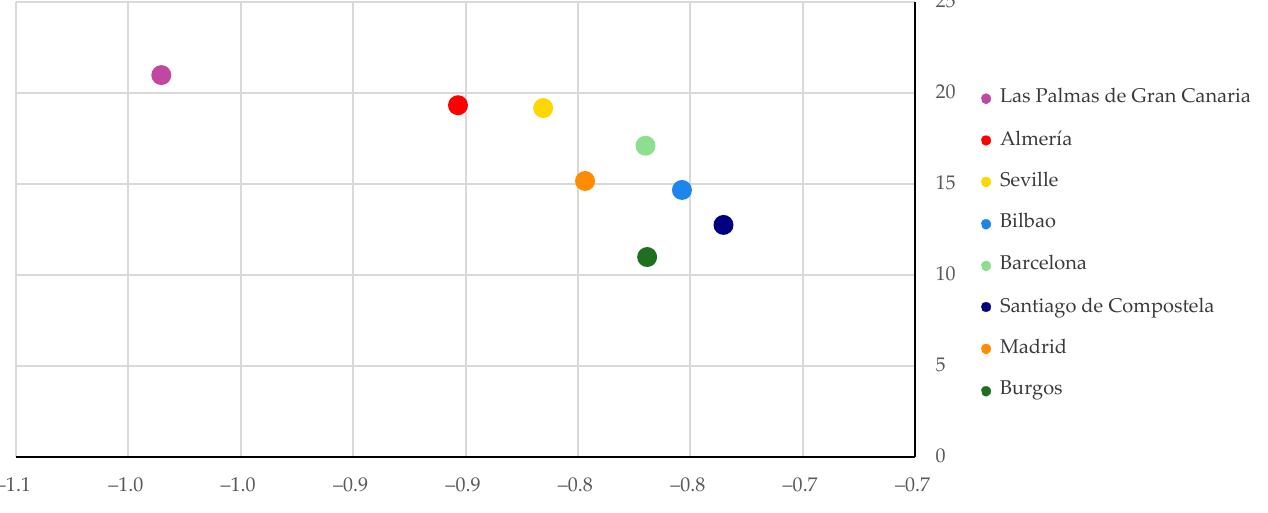
Figure 6. Heat losses due to evapotranspiration (W/m 2 ) in the extensive green roof of model B re- garding the average annual temperature (°C) in each of the 8 cities.